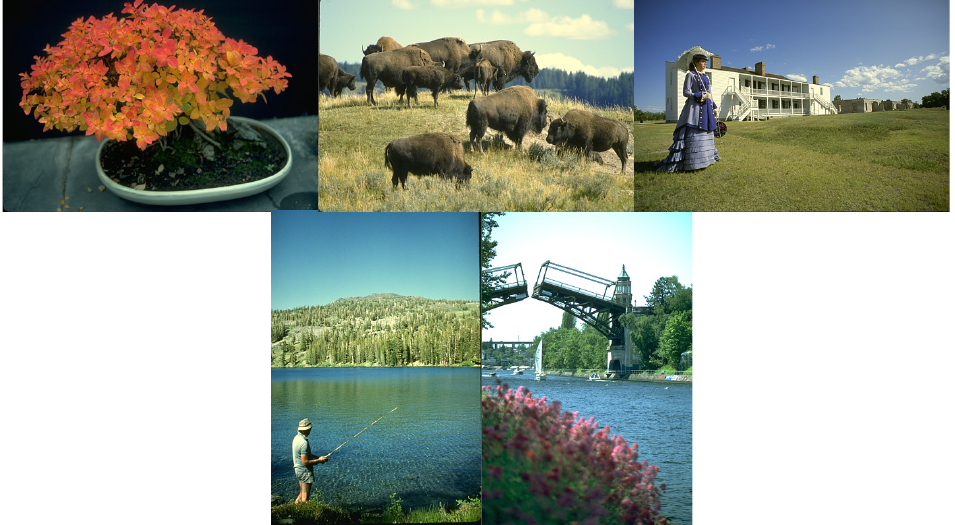
Figure 3. Showcase of selected images from [39]. First row: flower image (label 353013 ; herd image (label 38092 ); woman image (label 216053 ). Second row: fisherman image (label 48055 ); bridge image (label 22093